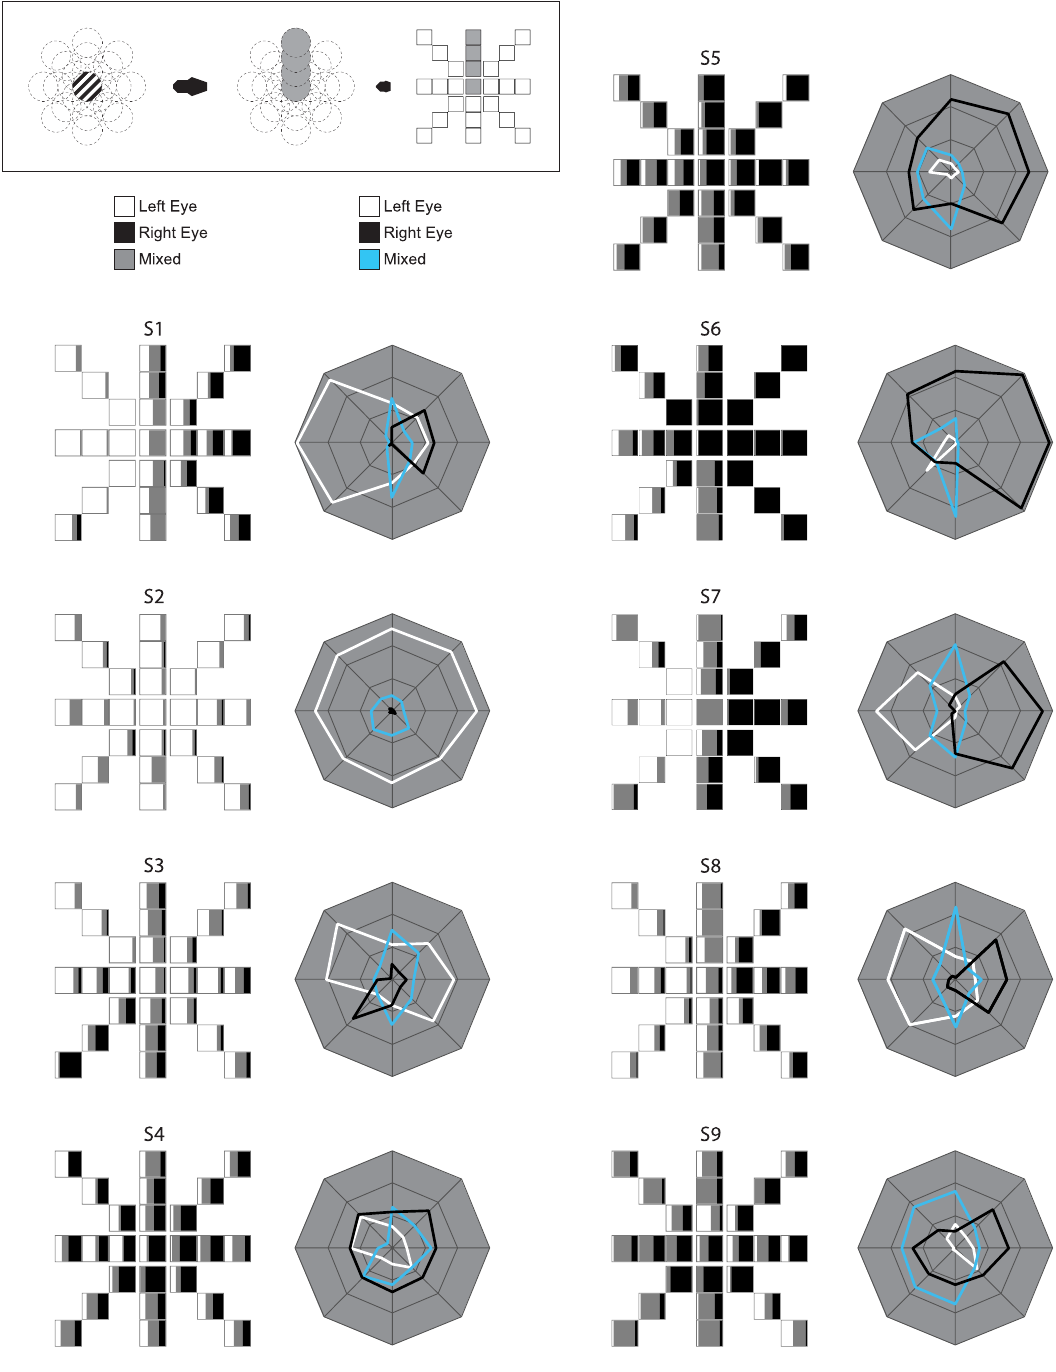
Figure 5. Individual Onset Rivalry Profiles: Raw data for individual observers. Boxes on the left represent each location tested, though spread out from their overlapping positions. Polar plots on the right represent each coordinate direction, but with eccentricities collapsed (and fixation omitted). Distance from the center indicates the average proportion of Left Eye, Right Eye, and Mixed Percept, respectively, across the three eccentricities at each coordinate.